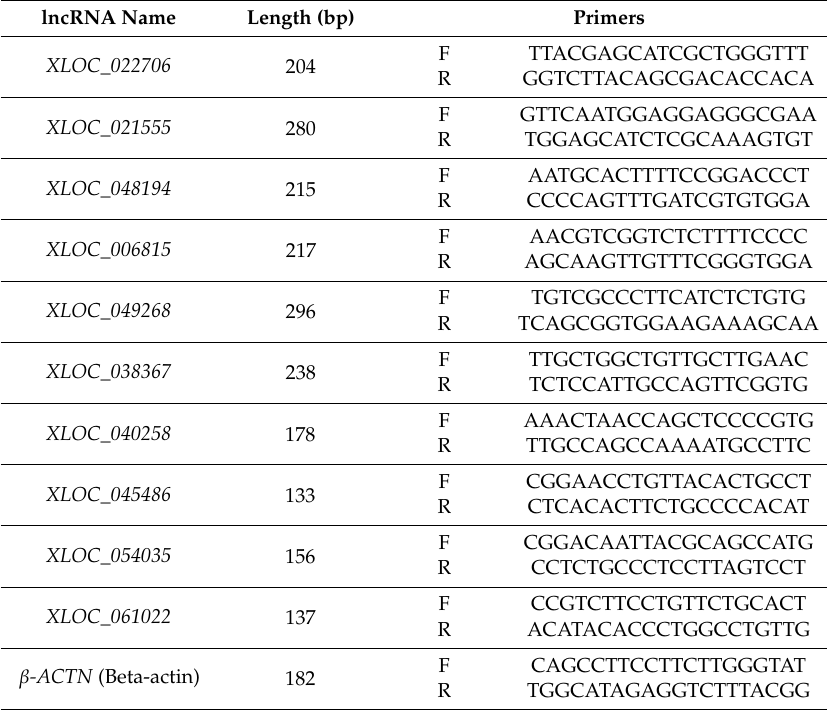
Table 1. Primers for quantitative real-time (qRT)-PCR